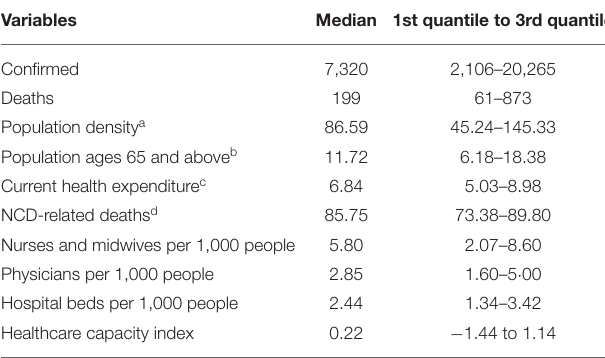
TABLE 1 | Summary statistics of selected variables ( n = 86). TABLE 2 | Estimated association between healthcare capacity and deaths adjusting for other covariates ( n =